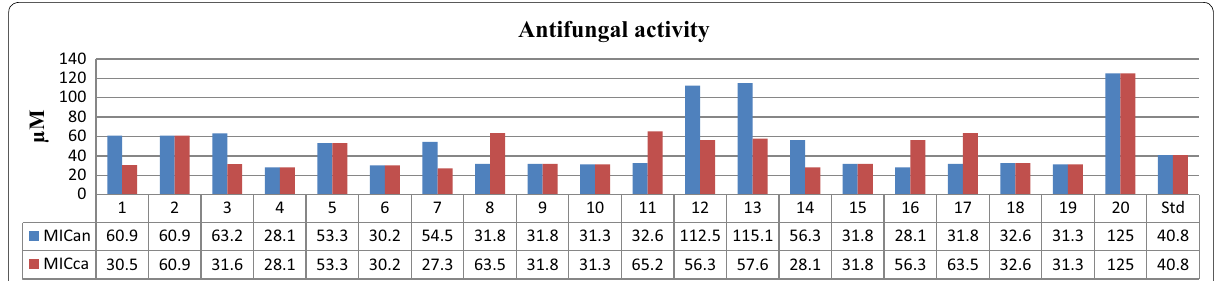
Fig. 3 Antifungal screening results of the synthesized benzoxazole derivatives